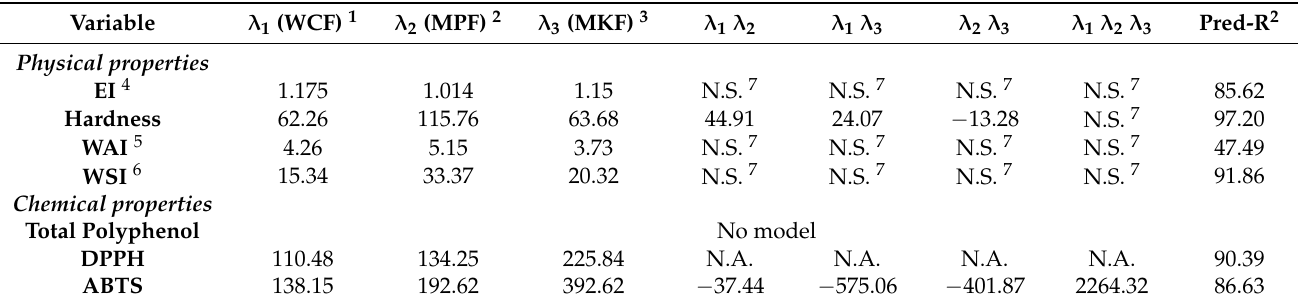
Table 4. Regression coefficients and correlation for the adjusted model to experimental data in D-optimal mixtures design for physical and chemical